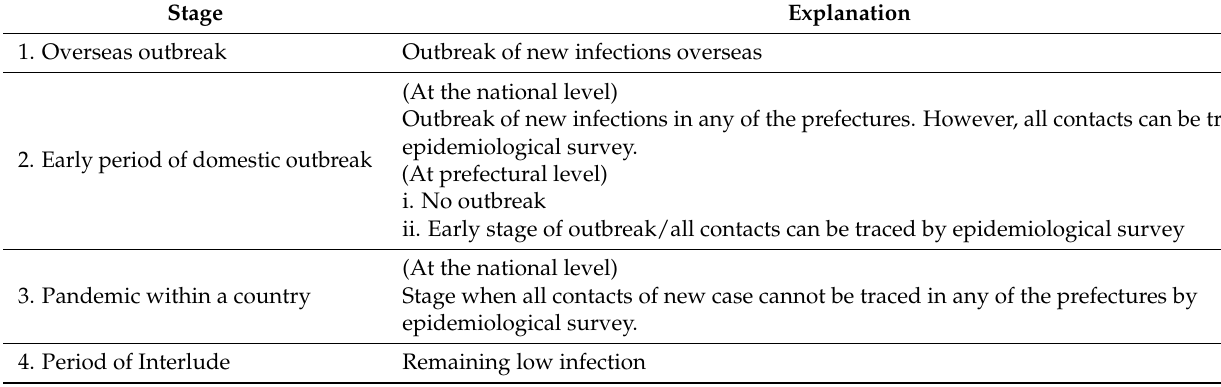
Table 1. Infection outbreak stage for H1N1 Influenza indicated in the Japanese government action plan